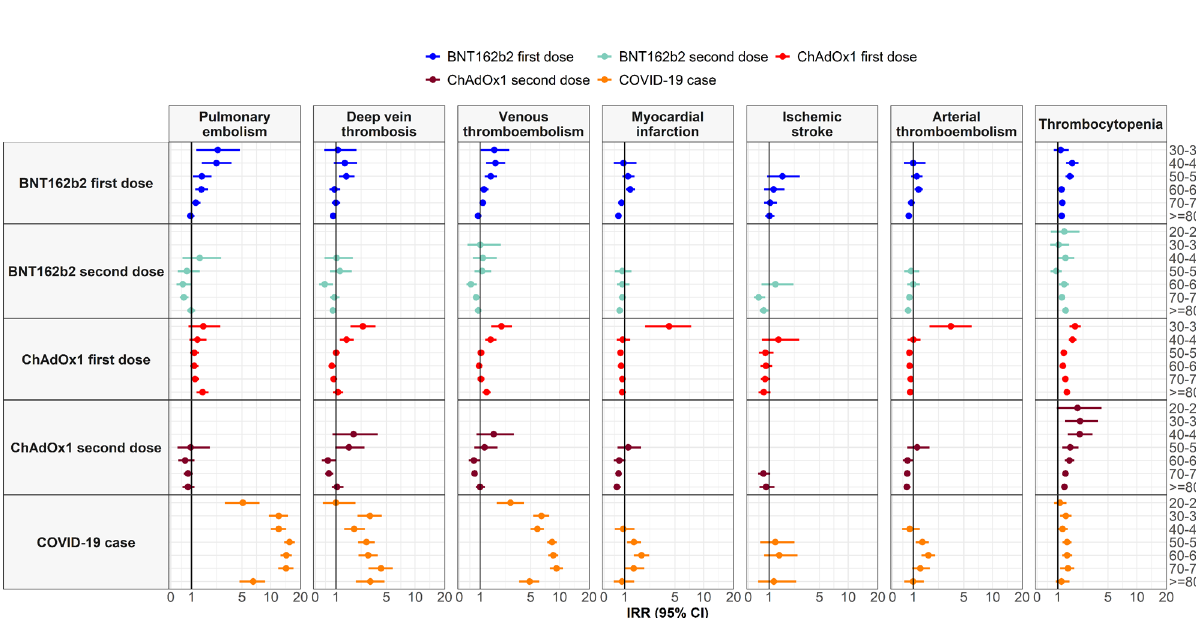
events seen in each cohort on the panels on the left. Corresponding standardized incidence ratios (SIRs) with 95% con fi dence intervals (95% CI) are shown in in the panels on the